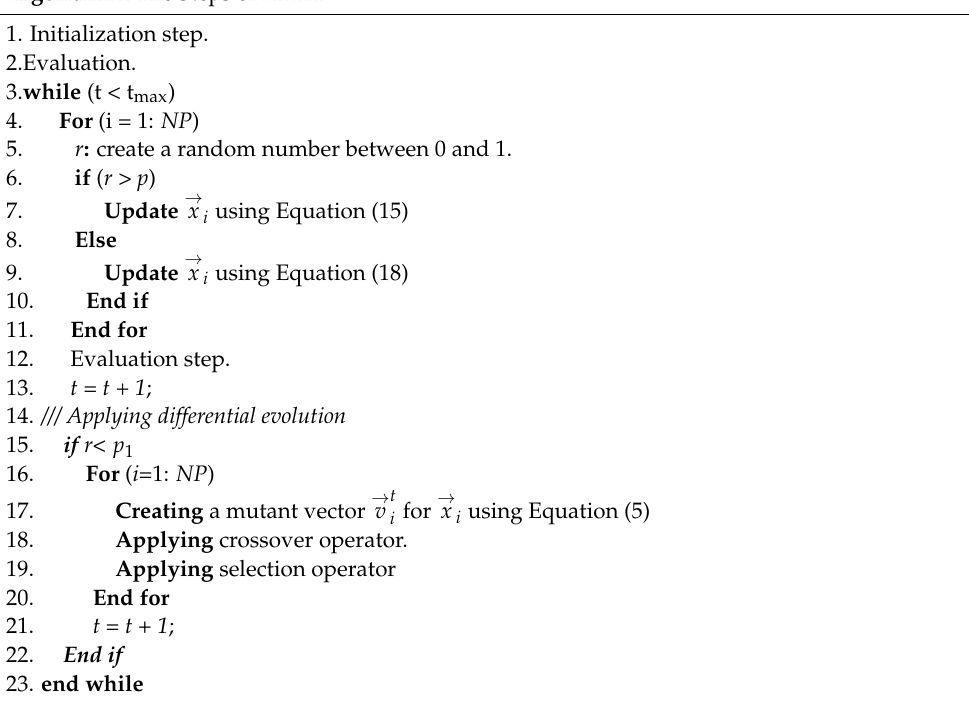
Algorithm 2 The Steps of